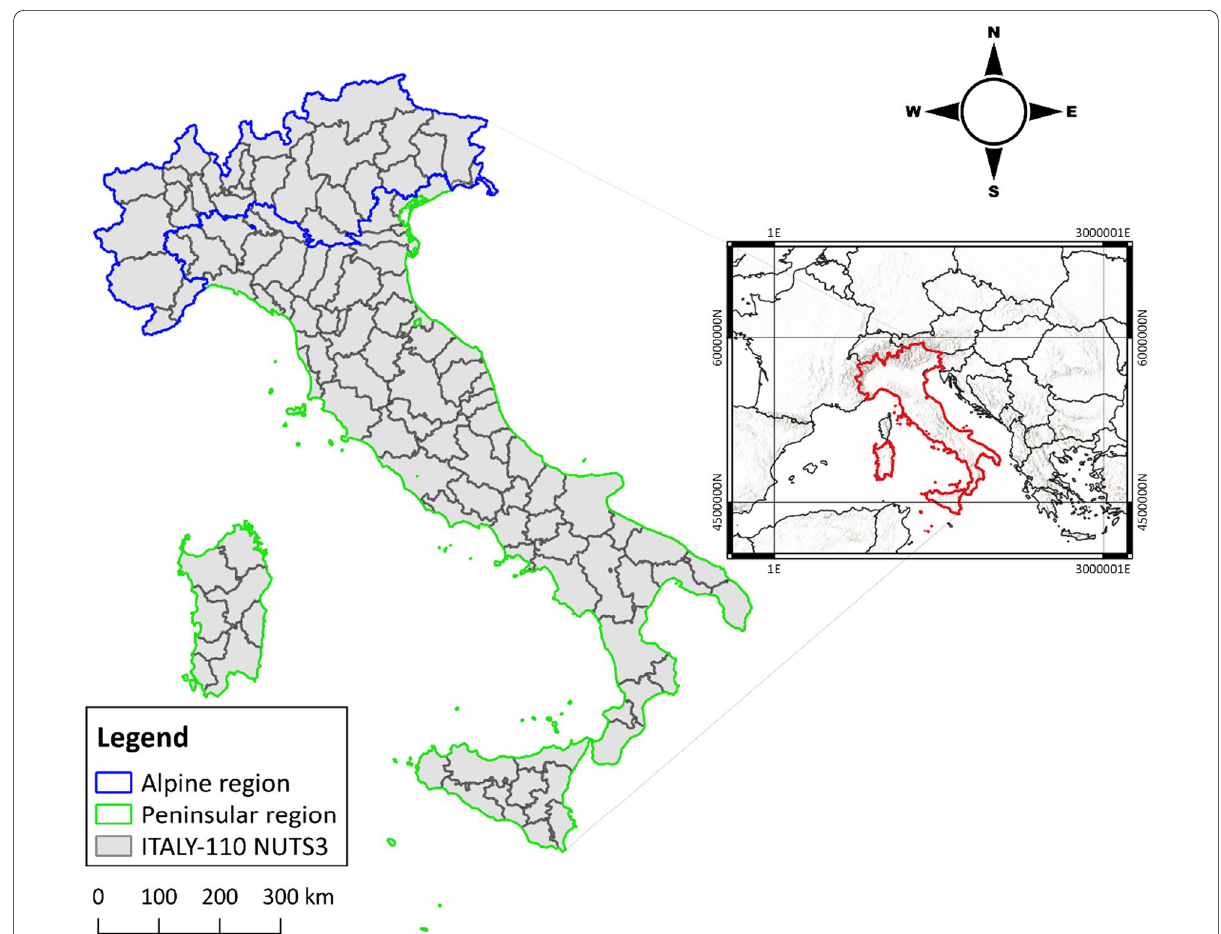
Fig. 2 The 110 Nomenclature of Territorial Units for Statistics, level 3, of the European Union, displayed in the Italian peninsula. The Alpine region and Peninsular region accounted for different climatic and environmental features, where wildfire seasonality metrics were